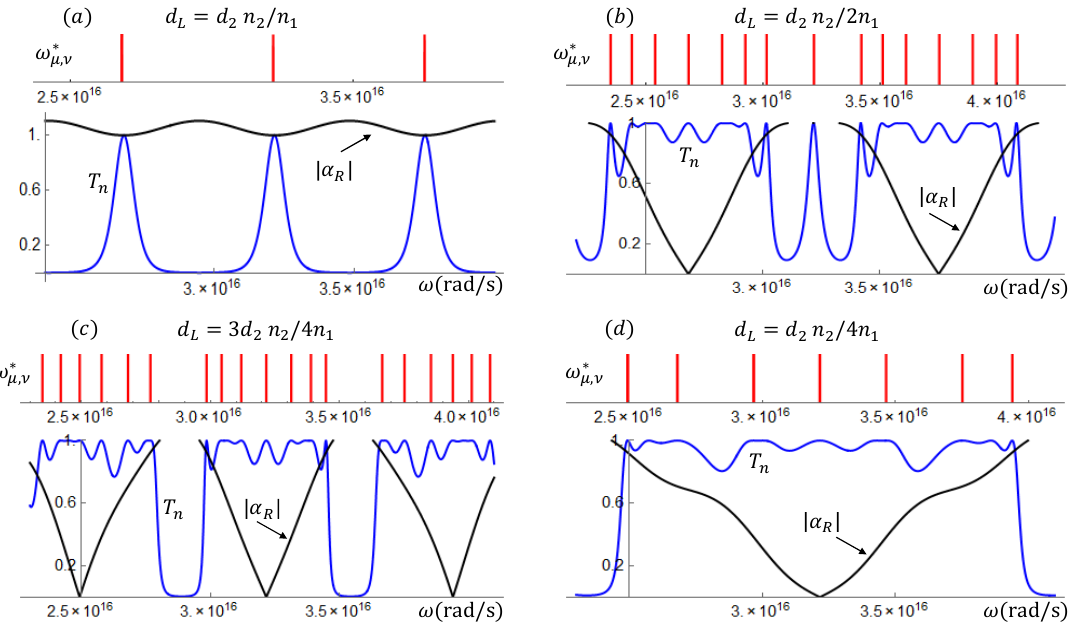
Figure A1. In this figure, we plot the transmission coefficient for the quarter λ relation d L = d 2 n 2 / n 1 and for other relations, indicated in the graphs. The resonant transmission coefficient (blue curves) are plotted along with the dispersion relations for an infinite periodic structure (black curves) and the RDR of the TFPS (red lines). In ( a ), the narrow bands in the quarter lambda limit agree with the predictions of the Kramer condition and with those of the RDR. In ( b – d ), we find again that the RDR predicts the resonances of the transmission